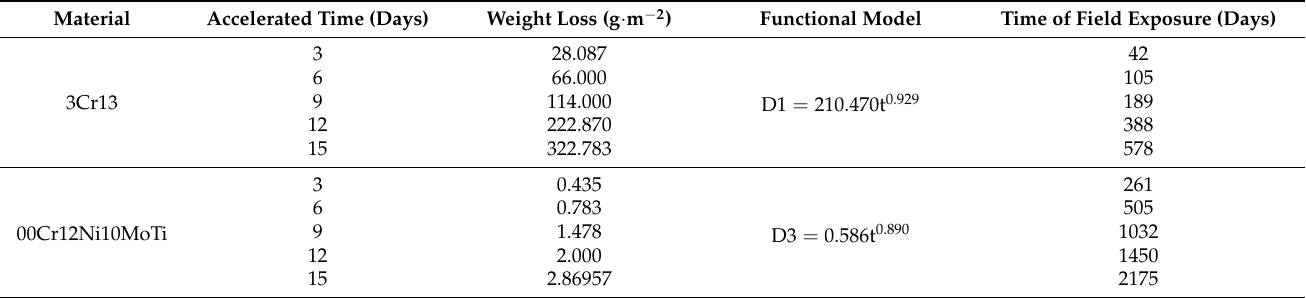
Table 8. Relationship between laboratory-accelerated corrosion time and field exposure time for two stainless steels.